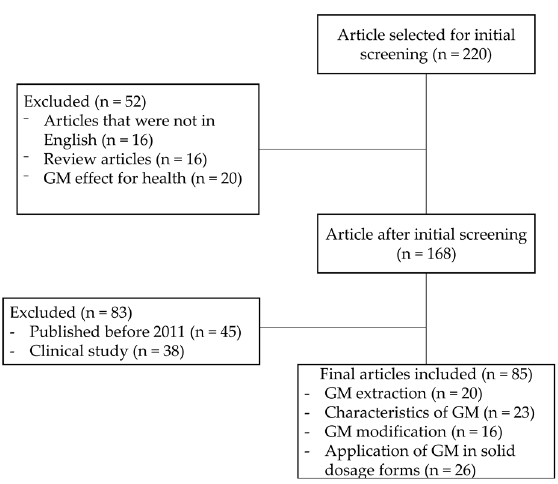
Figure 1. Flowchart of the inclusion and exclusion criteria for review